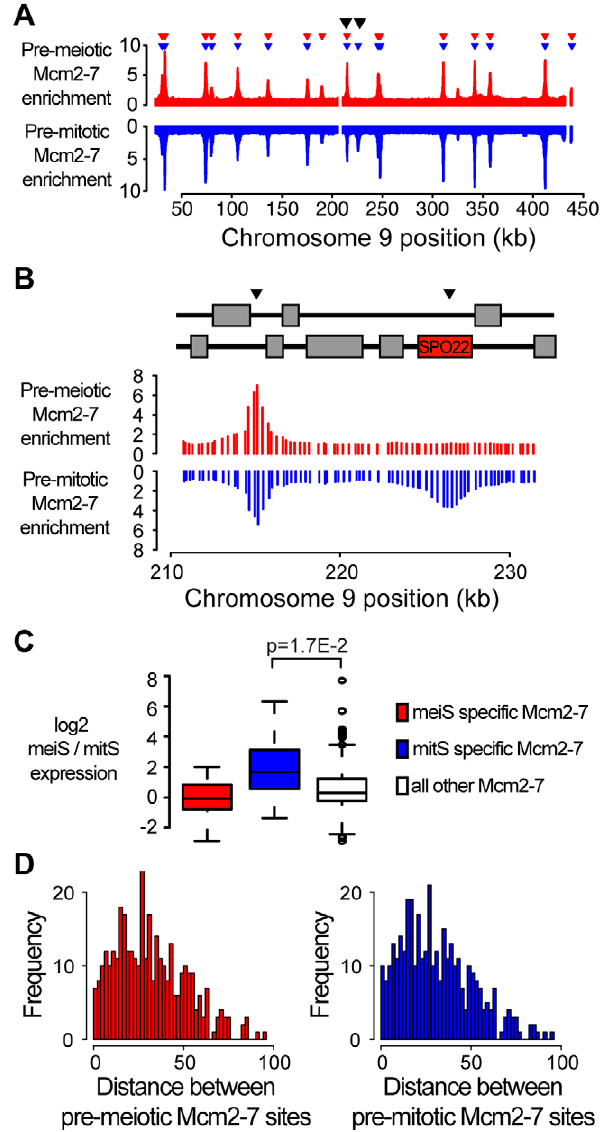
Figure 1. Transcription influences origin selection. (A) Mcm2-7 localization was performed for cln3 D cells (A4224) prior to meiosis and a wild-type strain (SB1505) prior to mitosis. Mcm2-7 enrichment was plotted versus chromosome position for chromosome IX for meiotic cells (red, enrichment is upwards) and mitotic cells (blue, enrichment is downwards). Inverted red and blue triangles indicate significant Mcm2- 7 binding sites. Black arrowheads indicate the positions of ARS913 and the SPO22 ARS. (B) As in (A), except a detailed view of ARS913 (left) and the SPO22 ARS (right) as indicated by arrowheads. The schematic above indicates the locations of coding regions. (C) Quantification of the change in gene expression for genes next to meiosis-specific (red), mitosis-specific (blue) and all other (white) Mcm2-7 binding sites. (D) Histogram showing the distribution of the calculated distances between Mcm2-7 binding sites prior to meiosis (red, left panel) and mitosis (blue, right panel).